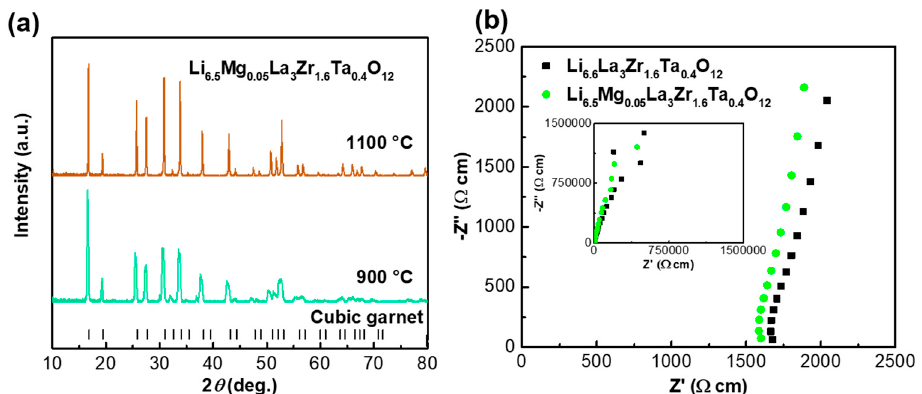
Figure 3. ( a ) XRD of Li 6.5 Mg 0.05 La 3 Zr 1.6 Ta 0.4 O 12 treated at 900 °C and 1100 °C. ( b ) Nyquist plots of Li 6.6 La 3 Zr 1.6 Ta 0.4 O 12 and Li 6.5 Mg 0.05 La 3 Zr 1.6 Ta 0.4 O 12 sintered by free sintering; the insets are impedance plots (10 Hz–1 MHz) measured in air at room temperature.